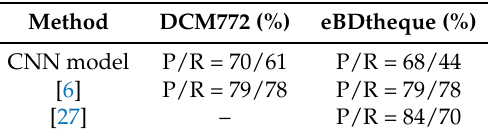
Figure 8. Result of panel detection on the eBDtheque dataset using the CNN model trained from the DCM772 dataset: The detected bounding boxes do not always fit the panel borders. Table 10. Panel detection evaluation on the eBDtheque dataset using Jaccard index; results for [27] are taken from the